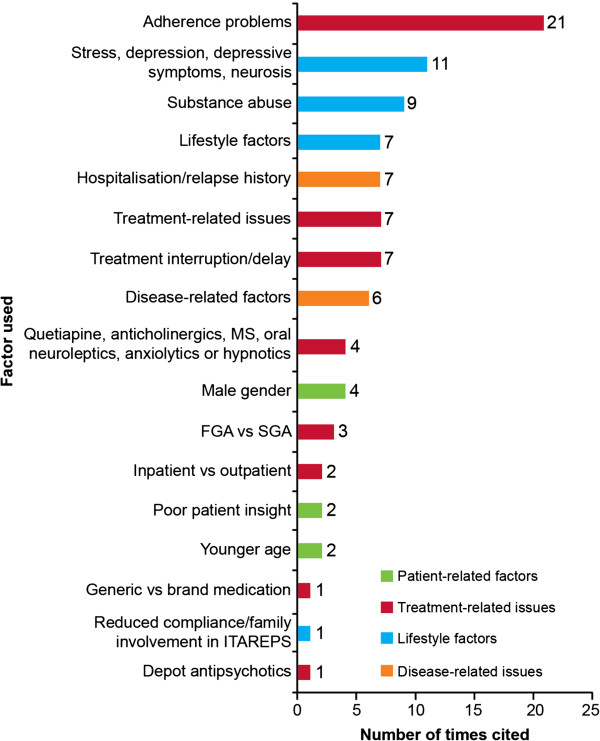
Potential drivers of relapse. Adherence problems [2,6,7,13,17,25,26,31],[34,45,47,53,57,76,85,100-105]; stress, depression, depressive symptoms, neurosis [2,6,7,12,55,59,70,97],[106-108]; substance abuse [2,6,7,21,31,57,59,83],[97]; lifestyle factors [7,12,21,38,79,109,110]; hospitalization or relapse history [21,31,38,40,57,59,97]; treatment-related issues [6,7,28,43,61,70,111]; treatment interruption or delay [2,6,12,75,85,112,113]; disease-related factors [57,70,83,85,97,114]; quetiapine, anticholinergics, mood stabilizers (MS), oral neuroleptics, anxiolytics or hypnotics [21,31,51,55]; male gender [30,37,83,115]; use of first-generation antipsychotics (FGA) vs second-generation antipsychotics (SGA) [30,85,116]; outpatient vs inpatient [29,39]; poor patient insight [20,83]; younger age [57,83]; generic vs branded medication [117]; reduced compliance/family involvement in Information Technology Aided Relapse Prevention in Schizophrenia (ITAREPS) programme [53]; depot antipsychotics [76].